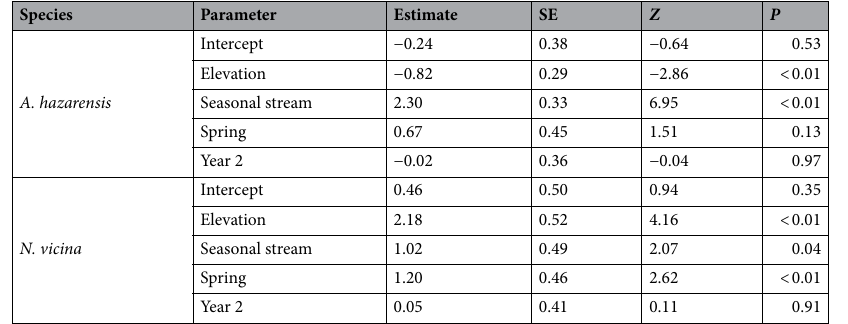
Table 5. Parameter estimates from the top-ranked (based on AIC) multispecies occupancy model for the Hazara Torrent Frog ( Allopaa hazarensis ) and Murree Hills Frog ( Nanorana vicina ) using eDNA data. Continuous covariates were standardized prior to analysis. The effects of “Seasonal stream” and “Spring” are relative to a baseline of permanent stream. The effect of year 2 is relative to a baseline of year 1. SE = Standard error, P = level of